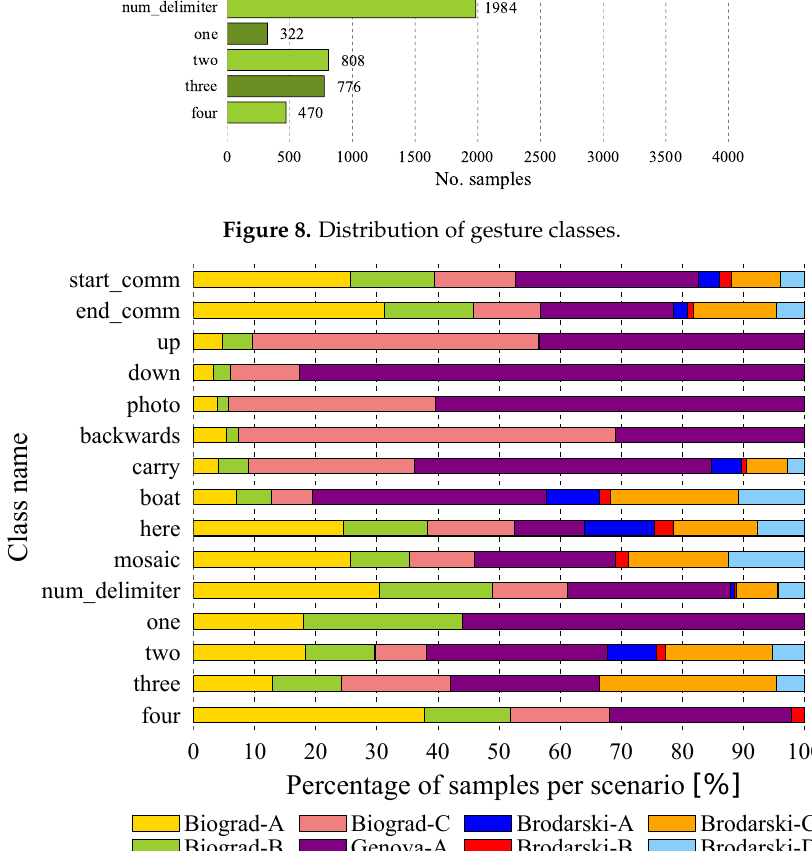
Figure 9. Distribution of classes per